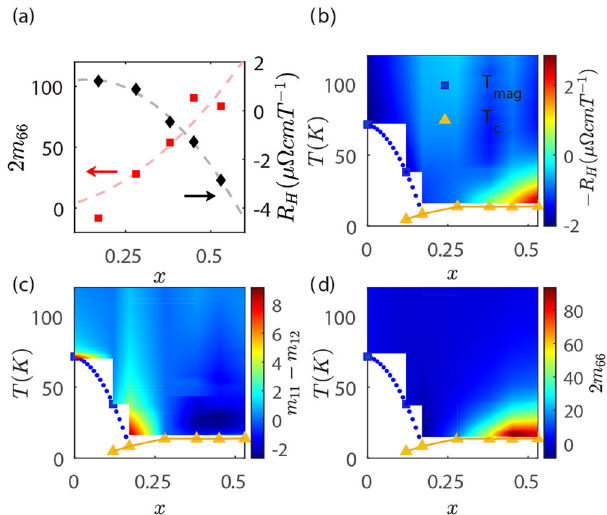
Fig. 3 Comparison between the elastoresistivity and the Hall coef fi cient R H . a Doping dependence of the B 2 g elastoresistivity coef squares) and of R H (black diamonds) at 16K. Dashed lines are guide to the eyes. b Colormap of the negative Hall coef fi cient - R H (raw data see Supplementary Note 5), c of m 11 − m 12 d and of 2 m 66 as a function of temperature and doping. The double-spin stripe and the superconducting transition temperatures are denoted as blue squares and yellow triangles, respectively.